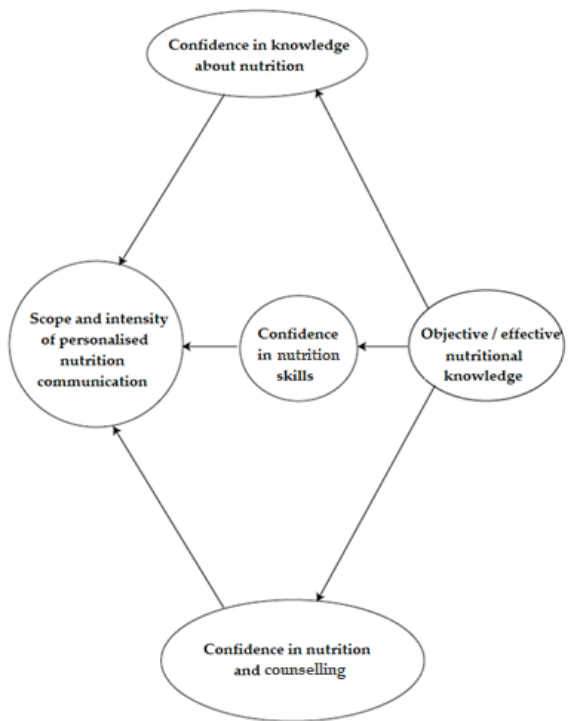
Figure 1. Visualisation of conceptual framework outlined in the H 3 and H 4 hypotheses.